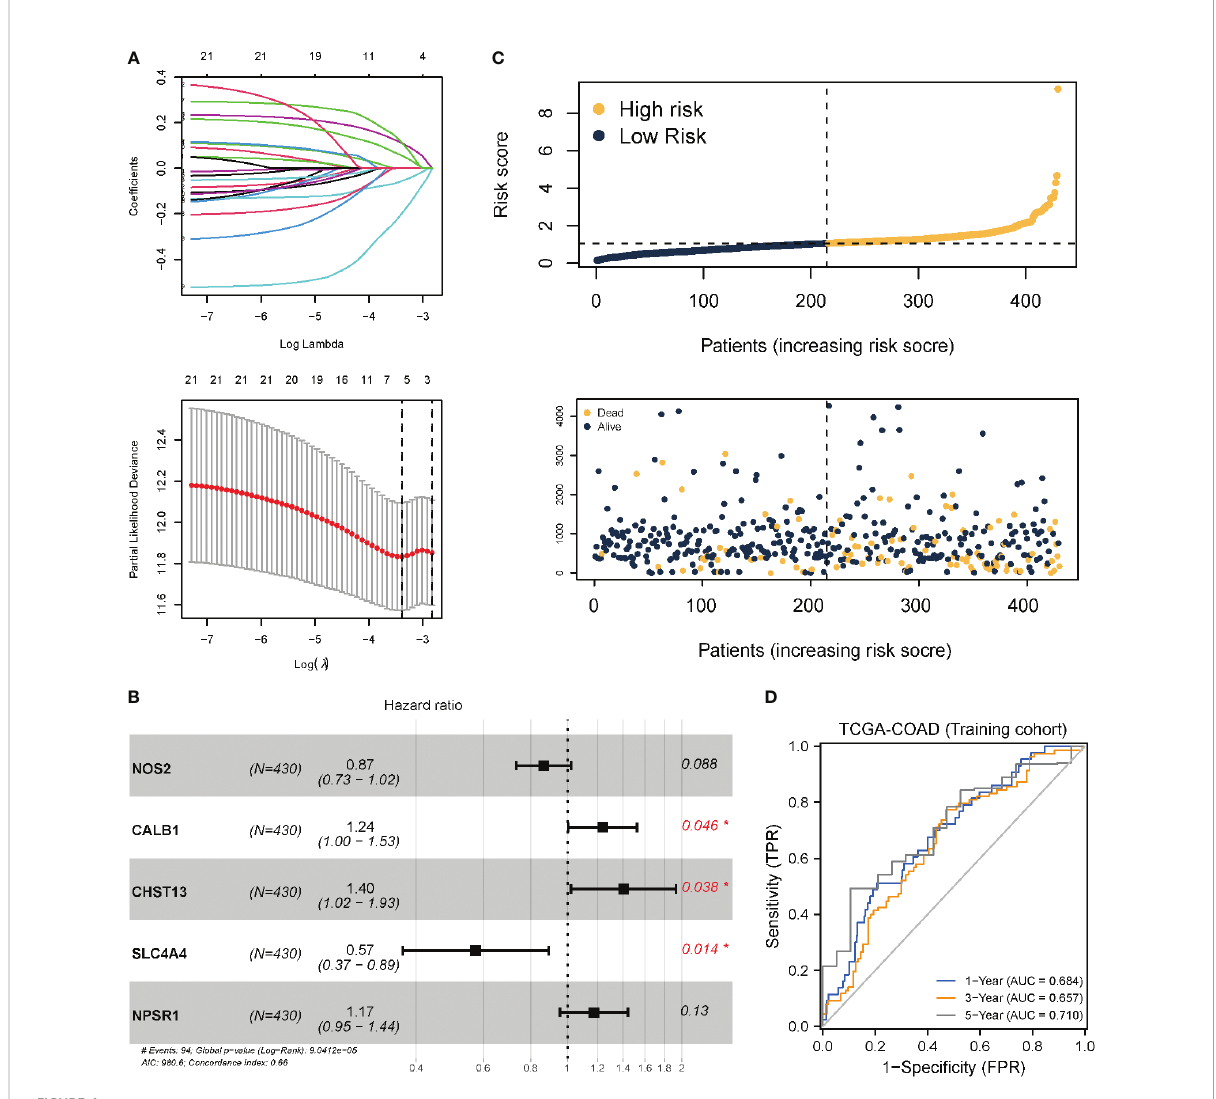
FIGURE 4 Prognostic model and model test based on necroptotic characteristic genes. (A) LASSO regression analysis; the number of variables corresponding to the optimal l value is 5. (B) Three genes identi fi ed as independent prognostic factors through multivariate Cox stepwise regression analysis. *P < 0.05. (C) Risk score distribution and survival status of COAD patients; (D) TimeROC curve of TCGA-COAD (training set). Internal validation was performed using the Bootstrap method, with 1000